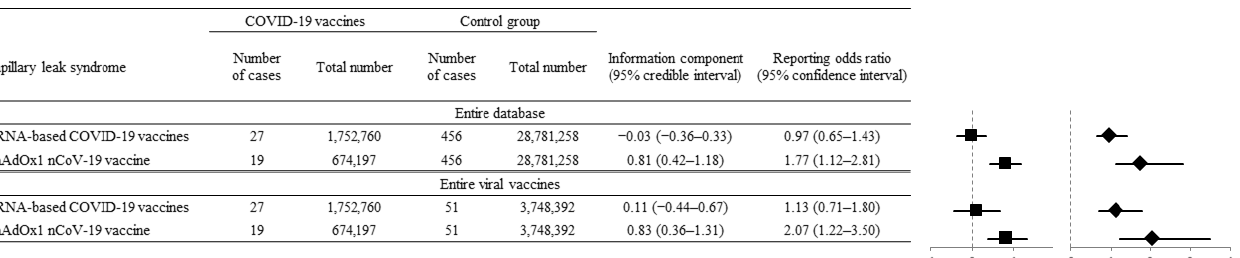
Figure 2. Disproportionality analysis between mRNA-based vaccines and ChAdOx1 nCoV-19 vaccine to compare systemic capillary leak syndrome (SCLS) occurrence. Forest plot with the reporting odds ratio (ROR, diamonds) and information component (IC, squares) values of mRNA-based (BNT162b2, mRNA-1273) and ChAdOx1 nCoV-19 vaccine-associated SCLS versus those from the entire database and all recorded viral vaccines. The ChAdOx1 nCoV-19 vaccine showed a significantly positive association with SCLS by IC 025 of 0.71 (95% CI, 0.24 – 1.12) and ROR 025 of 1.68 (95% CI, 1.23 – 2.29).